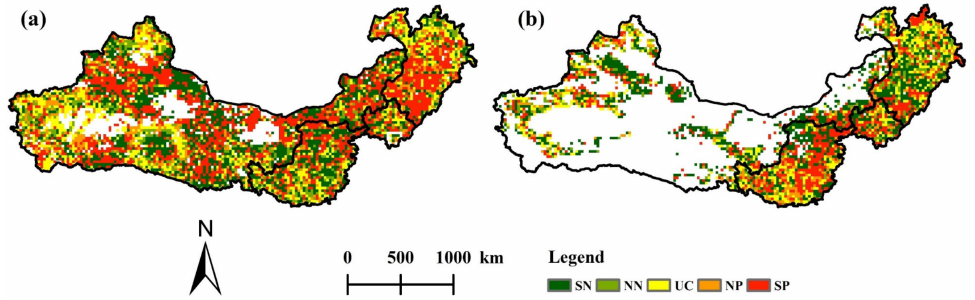
Figure 11. Spatial correlations between wind erosion and ( a ) intensity of grazing activities and ( b ) agricultural activities (SN: significant negative correlation; NN: nonsignificant negative correlation; UC: uncorrelated; NP: nonsignificant positive correlation; SP: significant positive correlation). Over 13.41% ( p < 0.05) of the study area, a negative correlation between soil